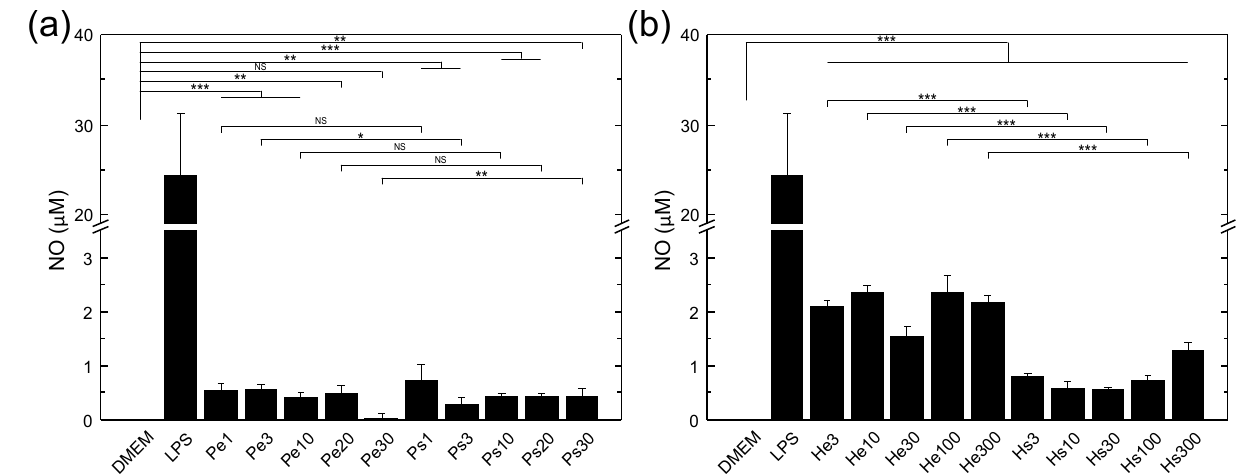
Figure 4. NO secretion of macrophages measured at 24 h after being treated with various vaccines produced by PDT ( a ) or H 2 O 2 ( b ) through spontaneous release or filter extrusion. DMEM: medium only; LPS: with 100 ng/ml lipopolysaccharide (LPS); Pe1, Pe3, Pe10, Pe20, Pe30: vaccines prepared using PDT with 4 µ g/mL of verteporfin and a light fluence of 1, 3, 10, 20, and 30 J/cm 2 , respectively, followed by filter extrusion after 24 h of recovery time; Ps1, Ps3, Ps10, Ps20, Ps30: vaccines prepared using PDT with 4 µ g/mL of verteporfin and a light fluence of 1, 3, 10, 20, and 30 J/cm 2 , respectively, with the supernatant collected after 24 h of recovery time; He3, He10, He30, He100, and He300: vaccines prepared using 3, 10, 30, 100, and 300 µ M H 2 O 2 , respectively, followed by filter extrusion after 24 h of recovery time; Hs3, Hs10, Hs30, Hs100, and Hs300: vaccines prepared using 3, 10, 30, 100, and 300 µ M H 2 O 2 , respectively, with the supernatant collected after 24 h of recovery time. For the vaccine groups, each well contained 1 × 10 5 macrophages, and the nanovesicle vaccines made from 5.2 × 10 6 LLC cells. Data are expressed by mean ± SD (N = 4), NS: no significant difference, *: p -value < 0.05, **: p -value < 0.01, and ***: p -value < 0.001.